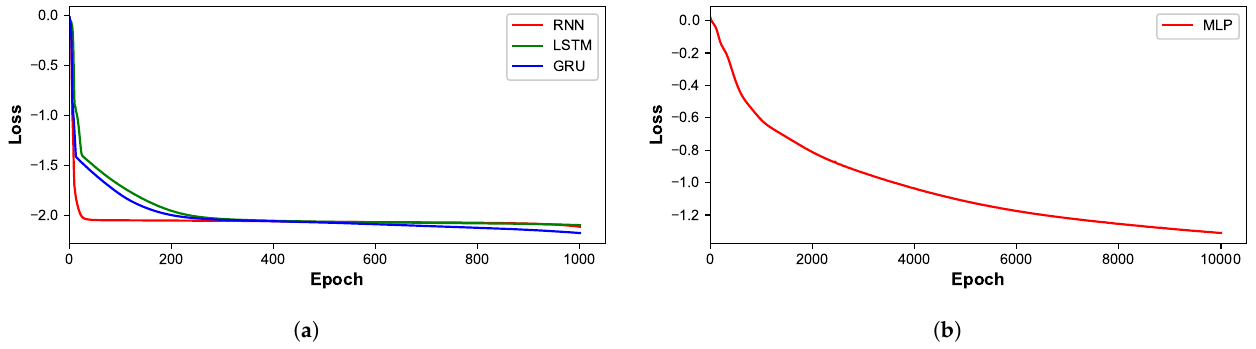
Figure 6. Learning curves: ( a ) Seq2Seq models; and ( b ) baseline